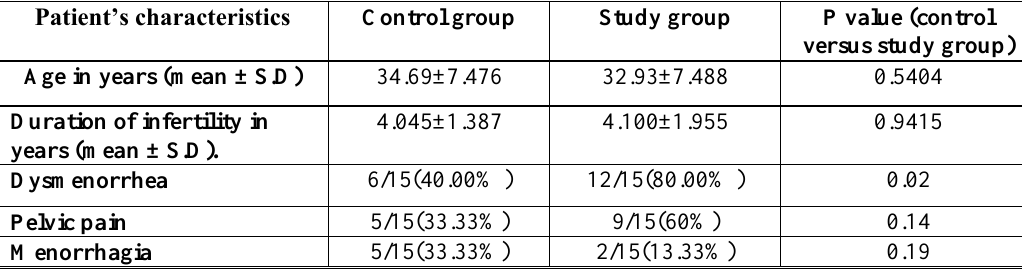
Table (3): Patient’s characteristics of women with endometriosis.